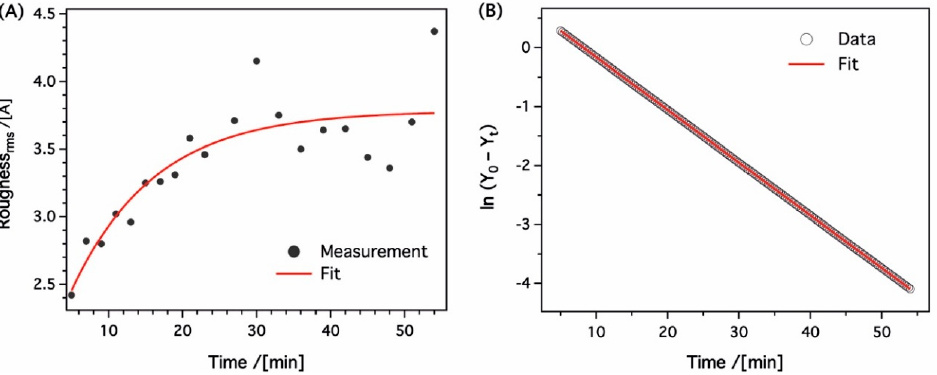
Figure 12. Kinetic evaluation of the washing process based on the surface roughness change of the ultra-thin film during in-situ SFM measurement (Figure 11). The root mean square roughness rms is plotted against washing time ( A ), while ( B ) is the logarithmic plot versus washing time calculated from the exponential function obtained from ( A ) in order to extract the rate constant.